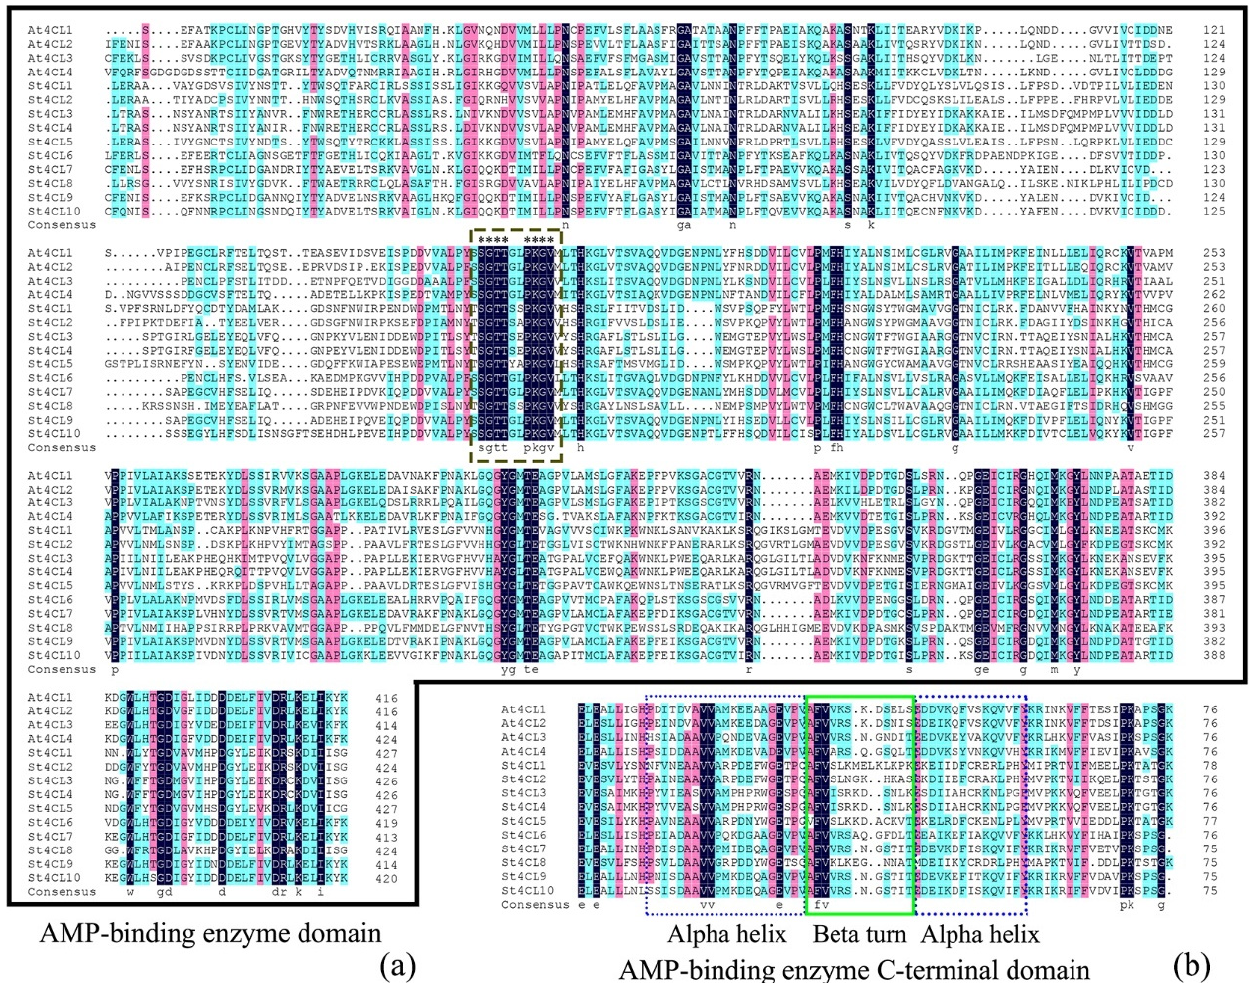
Figure 1. 4CL gene family domains in Arabidopsis and potato were used to multiple sequence alignment. ( a ) The AMP-binding enzyme domain amino acid sequences were aligned. The dashed boxes were conserved amino acid sequences. “ * ” were conserved amino acids in the AMP-binding enzyme domain. ( b ) The AMP-binding enzyme C-terminal domain amino acid sequences were aligned. The solid boxes were amino acid sequences corresponding to the Beta turn, and dashed boxes were amino acid sequences corresponding to the Alpha helices.